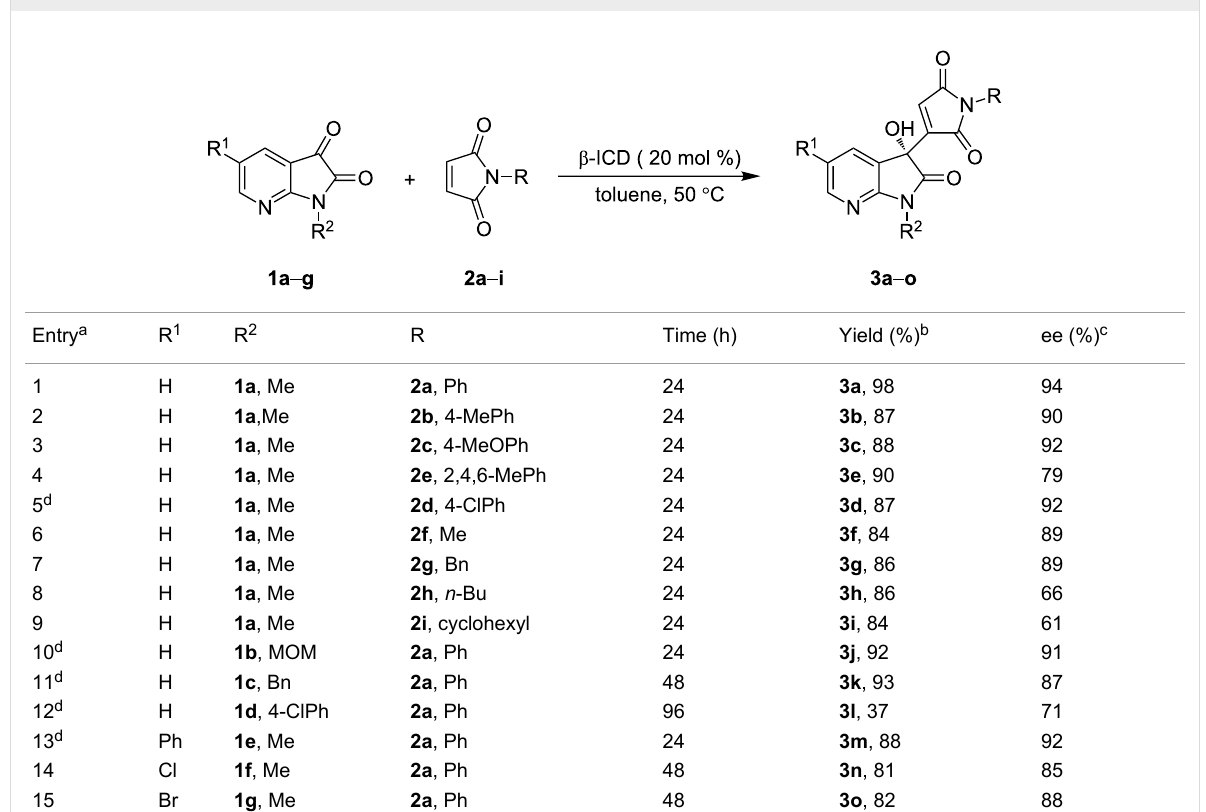
Table 2: Substrate scope of the enantioselective MBH